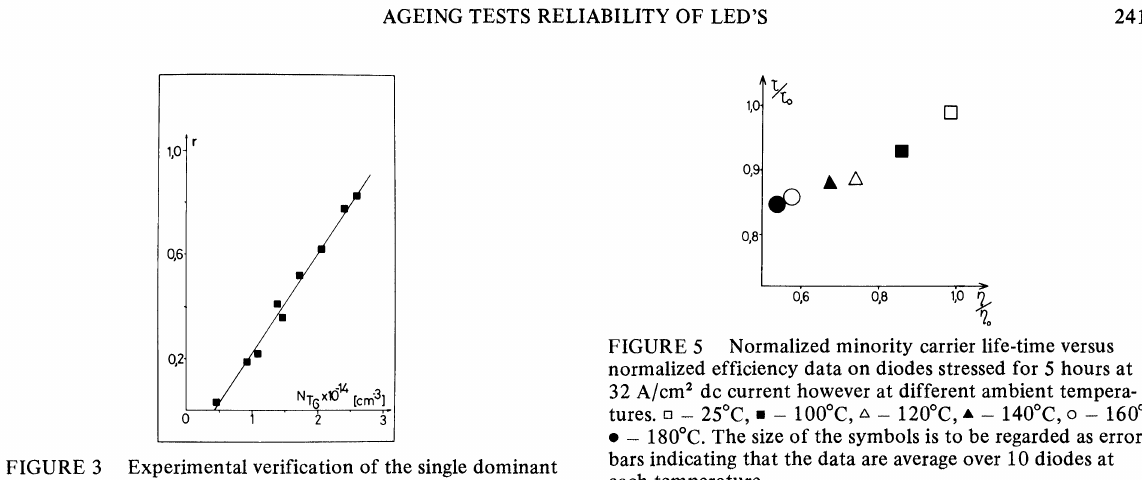
_ o16 o’,8 (o FIGURE 5 Normalized minority carrier life-time versus normalized efficiency data on diodes stressed for 5 hours at 32 A/cm dc current however at different ambient tempera- 140C, o 160C, tures. [] 25C, 100C, ,x_ 120C, 180C. The size of the symbols is to be regarded as error bars indicating that the data are average over 10 diodes at FIGURE 3 Experimentalverification of the single dominant each non-radiative channel model expressed by the equation: r.f.n/n r apVNT where fn,, is the normalized l’’e-time of the virgin erlclency, r0 is the minority carrier diode, ap is the hole capture cross section, v is the thermal drift velocity and NT denotes the measured trap concentration.